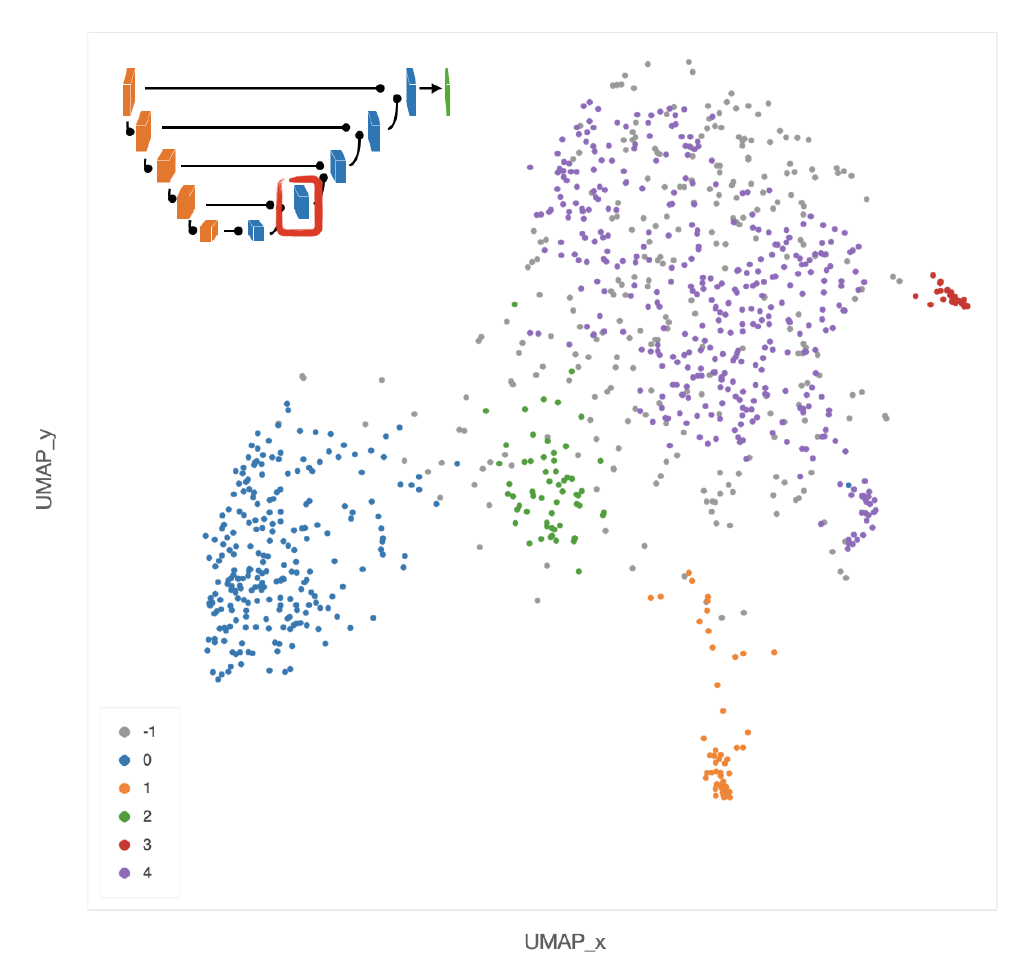
Figure 8. UMAP 2-dimensional embedding of a deep EUNet layer with cosine metric, and HDBSCAN clustering as- signments. Gray points (label − 1) are classified as noise by the clustering algorithm, while colored points belong to the clusters 0–4 detailed in Figures 9–13: stroma rich areas with low TILS level (0), tissue with septa infiltration (1), tissue with pseudo-necrotic tissue infiltration (2), intermediate level of lymphocyte infiltration in stroma poor areas (3) and low level of infiltration in stroma poor areas (4). In the upper-left corner, the graphical schema of the corresponding layer in